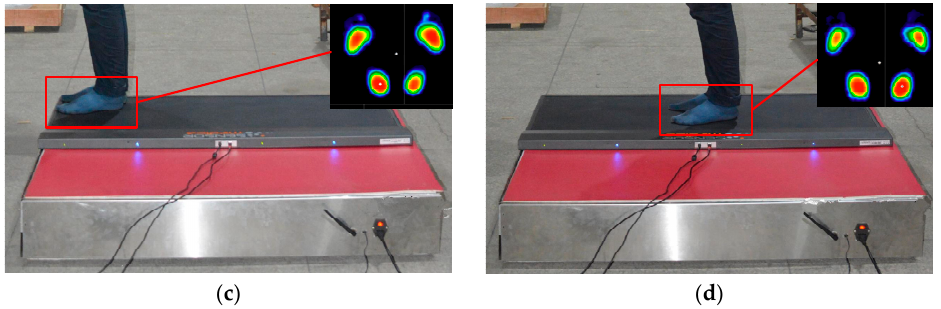
Figure 16. Force plate measurements with person standing at ( a ) Position 1; ( b ) Position 2; ( c ) Position 3; and ( d ) Position 4.